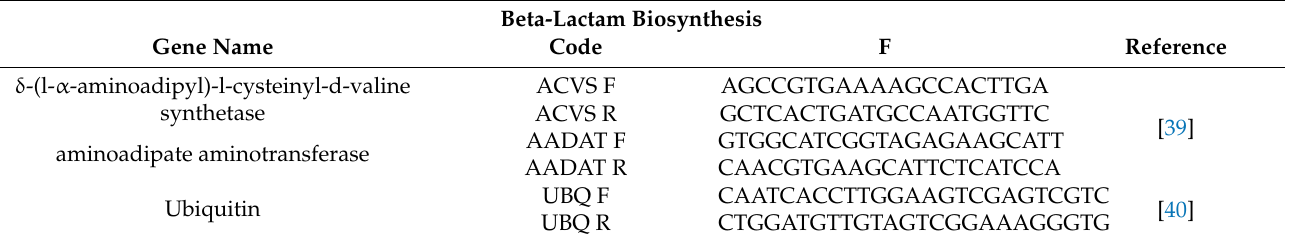
Table 1. Primers of the beta-lactam pathway genes ( δ -(l- α -aminoadipyl)-l-cysteinyl-d-valine syn- thetase (ACVS) and aminoadipate aminotransferase (AADAT)) used for qRT PCR analysis. Beta-Lactam